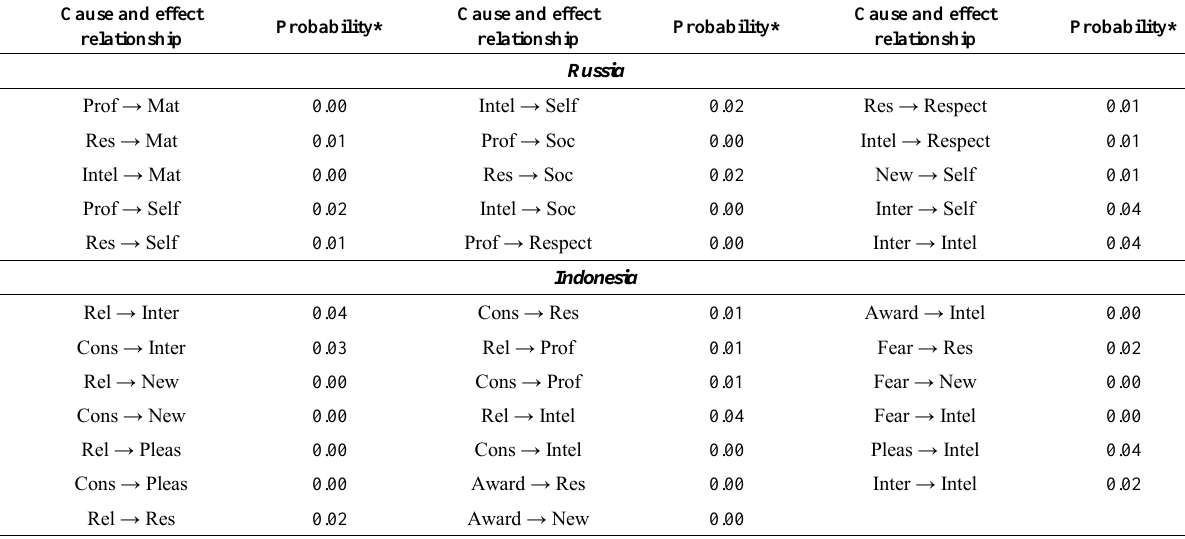
Table 5. Significant causal relationships between motivation factors and integral indicators of professional competencies